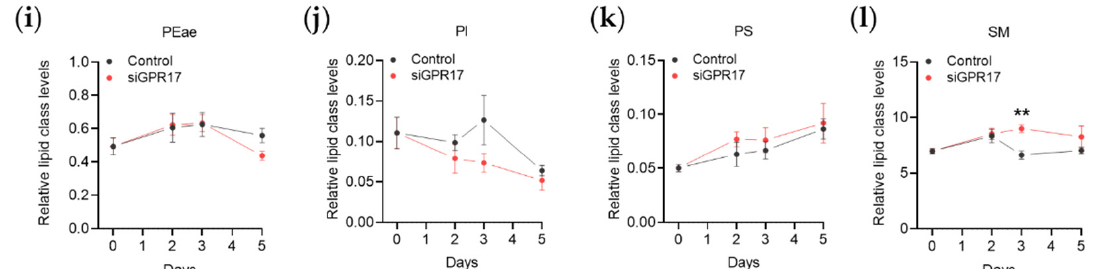
Figure 7. Changes in lipidic classes abundance induced by GPR17 silencing during OPC differenti- ation. The abundance of each lipid class in control conditions at different time points is reported ( a ). The kinetics of each lipid class after GPR17 silencing were analysed: ( b ) fatty acids, ( c ) ceramides,